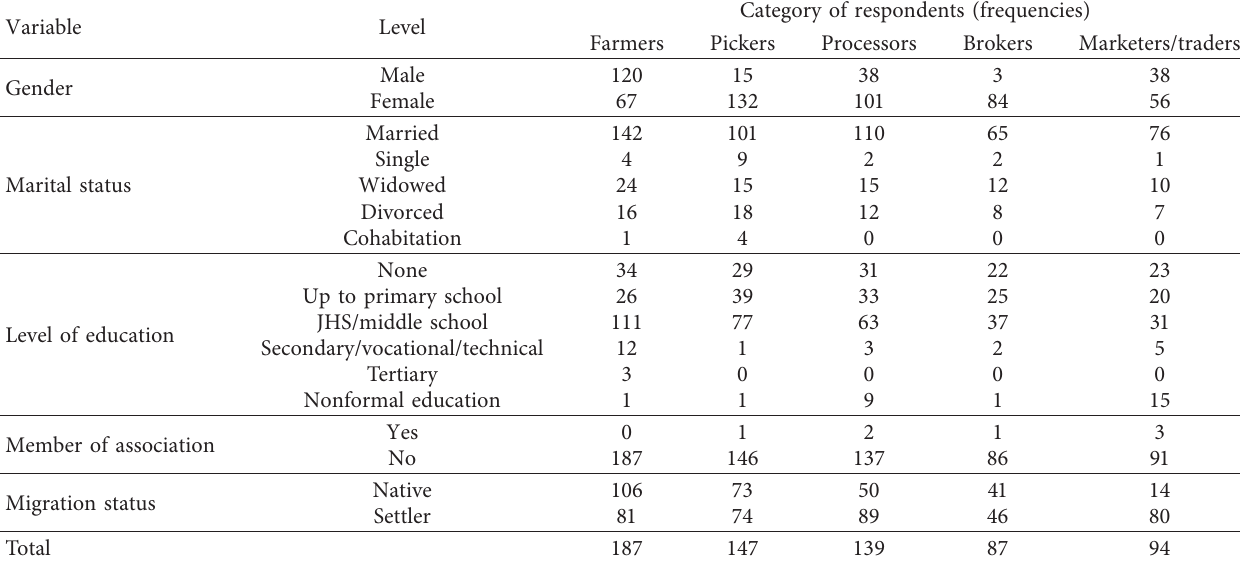
Table 2: Characteristics of respondents.